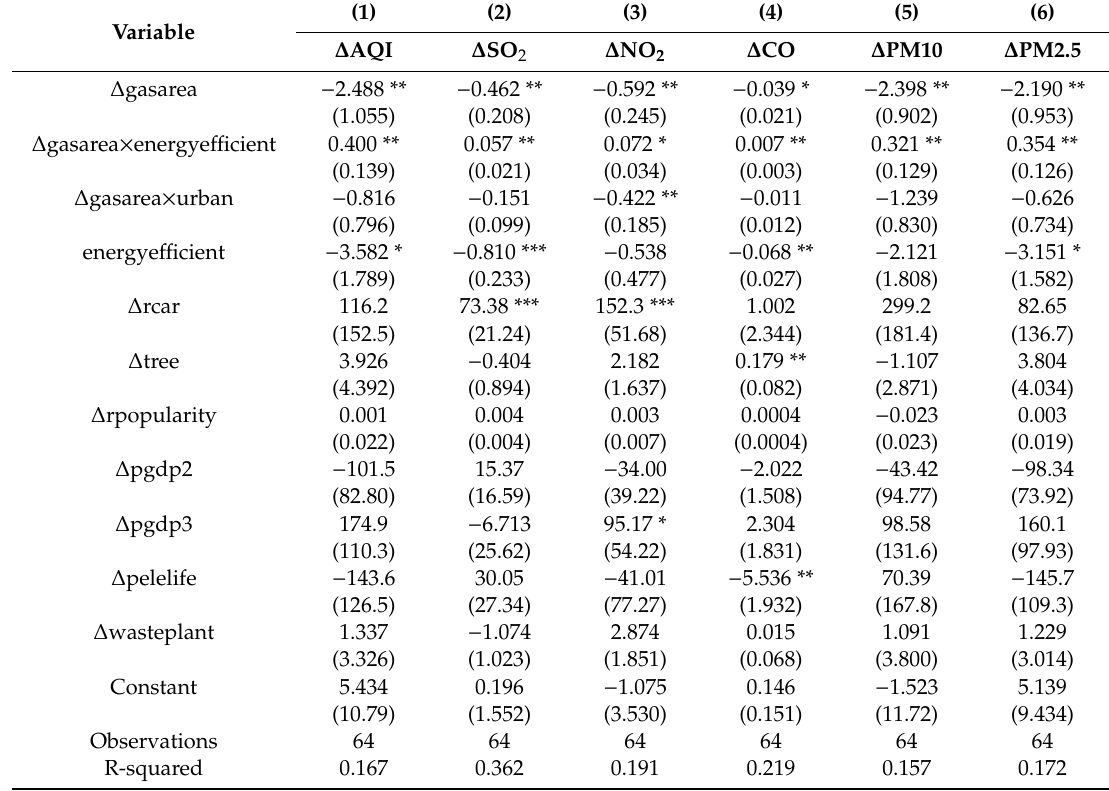
Table 3. Estimated impact of “coal to gas” policy on air